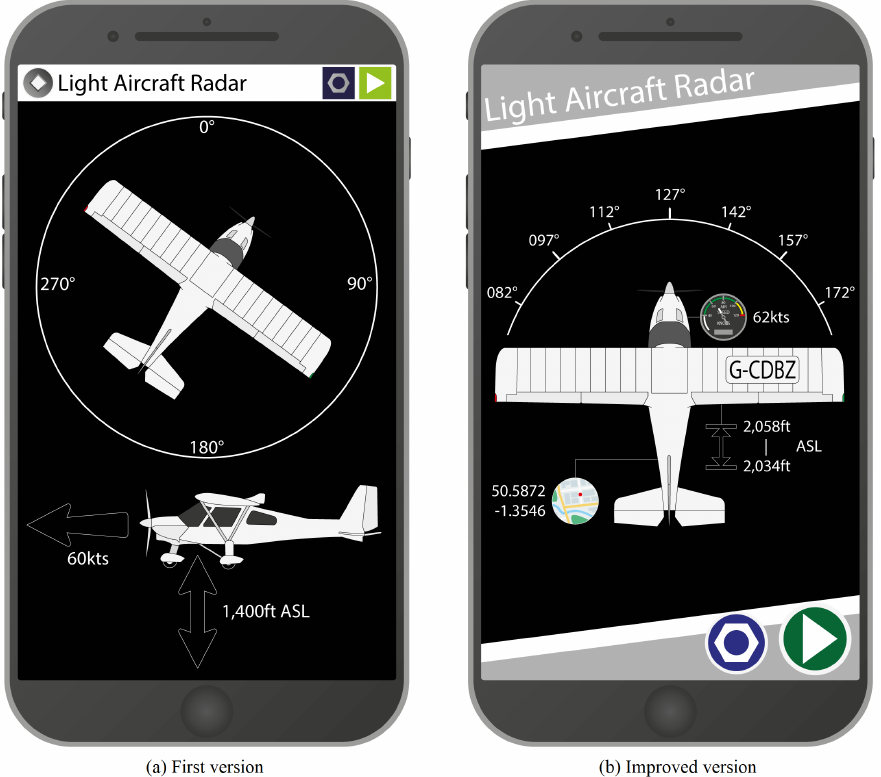
Figure 6. Low-fidelity prototype of the mobile application.